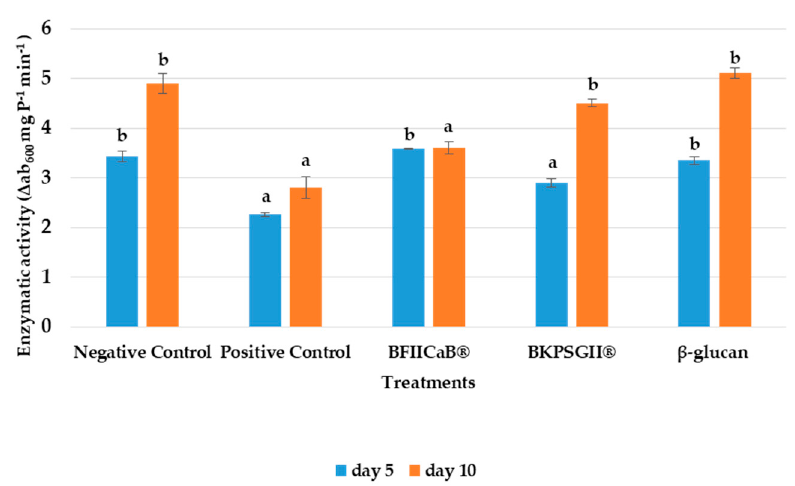
Figure 3. Peroxidase induced activity in tomato plants inoculated with FOL were evaluated 5 and 10 DAI. Plants were treated with distilled water (negative control), Serenade ® (positive control), β -glucan, BFIICaB ® and BKPSGII ® . a , b : Equal letters indicate no significant differences at the p -value < 0.05. The statistical analysis was performed separately for each time interval after treatment (average ± SD; n = 3).